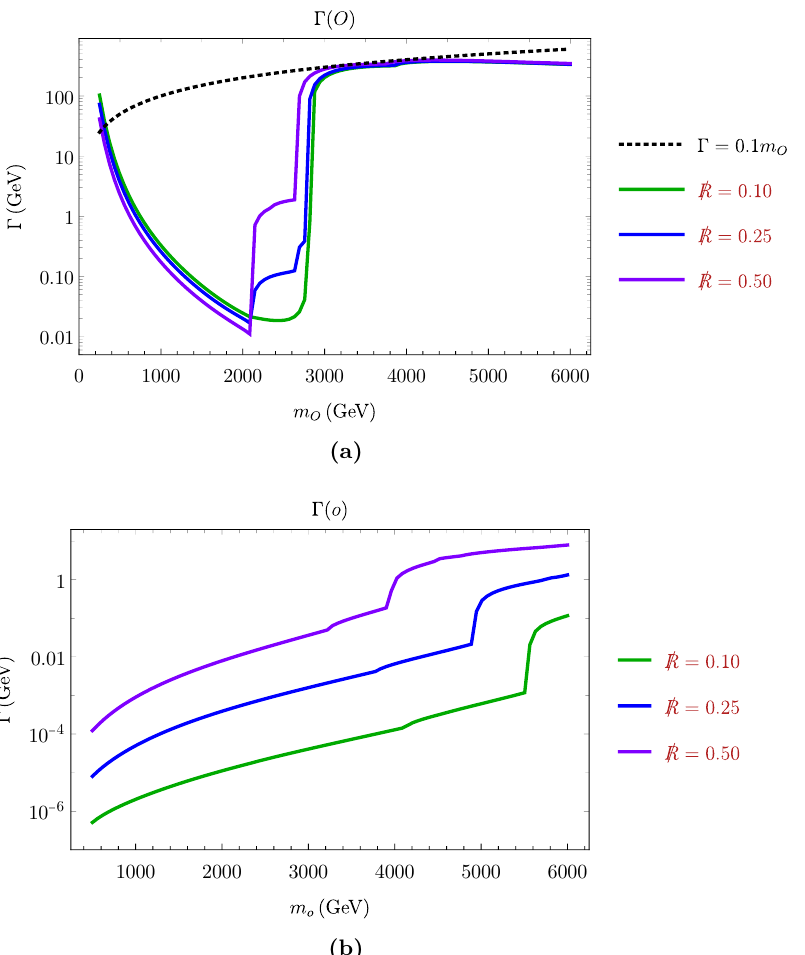
Figure 6. Decay widths of the (a) scalar and (b) pseudoscalar sgluons in Benchmarks 1, 2, and 3 with /R = 0.10 , /R = 0.25 , and /R = 0.50